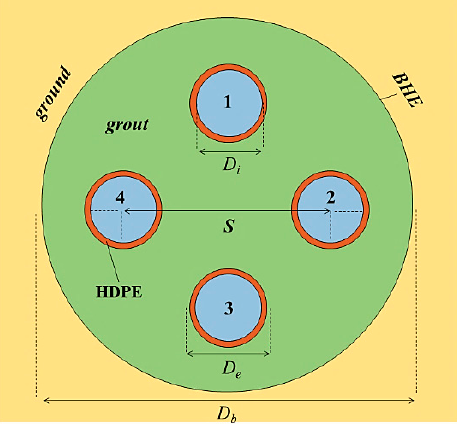
Figure 1. Sketch of the borehole heat exchanger (BHE) cross-section.